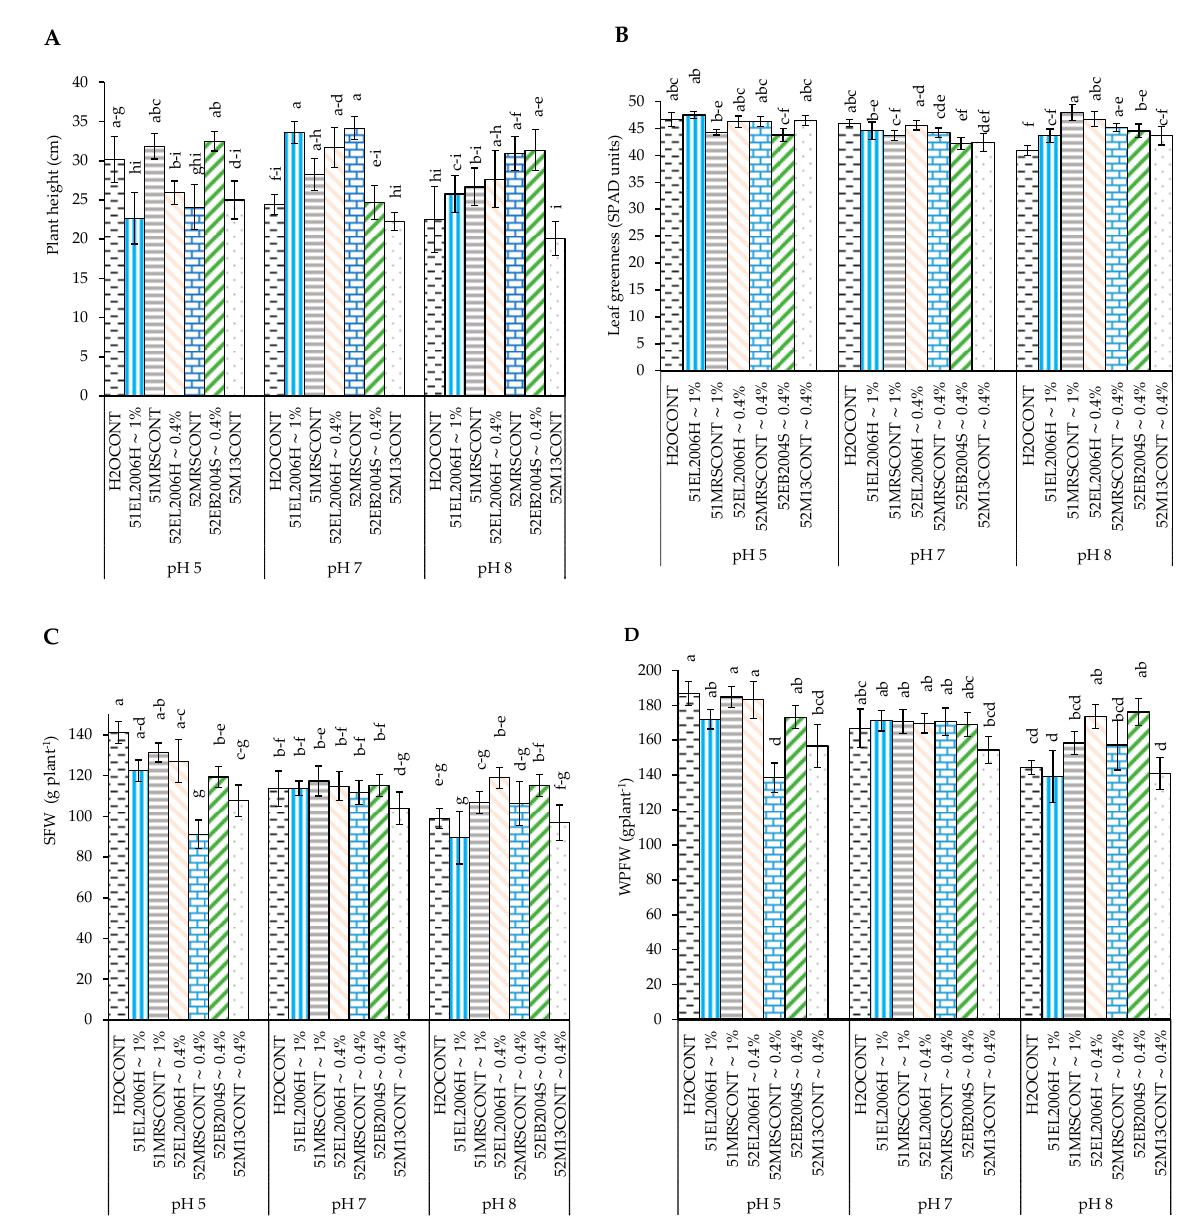
Figure 1. The interaction effect of pH and CFS treatments obtained from the cultured L. helveticus and B. subtilis (Experiment 1) at pH 5 on ( A ) potato plant height; ( B ) leaf greenness measured in SPAD units; ( C ) shoot fresh weight (SFW*); and ( D ) whole plant dry matter (WPDM*) under greenhouse conditions. Values are expressed in their respective units and means, dissimilar letters indicate significant ( p = 0.05, LSD) differences among treatments. Error bars represent standard error of means (SEM).